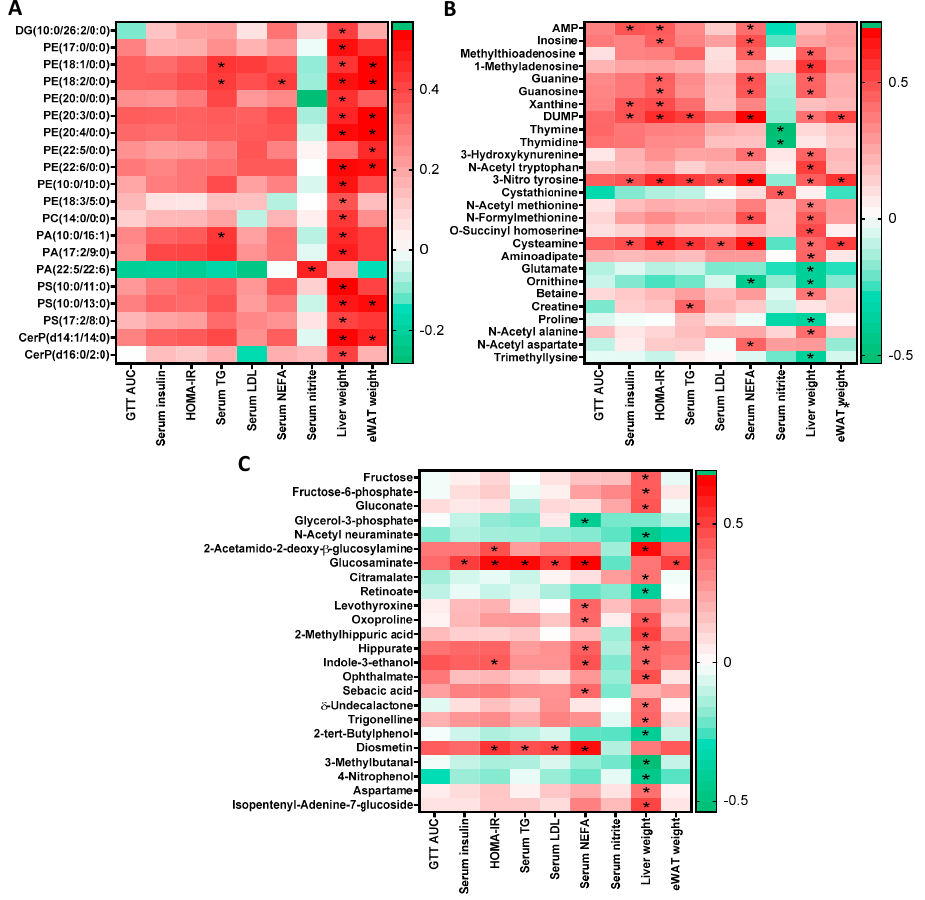
Figure 7. Association of serum metabolites with metabolic profile of iNOS -/- mice following treatment with various interventions. Heat map and analysis based on Pearson’s correlation coefficients suggest direct correlation between metabolic biomarkers and serum metabolites from WT, iNOS -/- mice following treatment with various interventions. ( A ) Lipid metabolism, ( B ) Nucleic acid and amino acid metabolism and ( C ) Carbohydrate metabolism, vitamins and hormones metabolism, and miscellaneous/microbiota derived metabolites. * p < 0.05 represent significant correlations between metabolic biomarker and serum metabolites. Green color represents negative and red positive correlations.